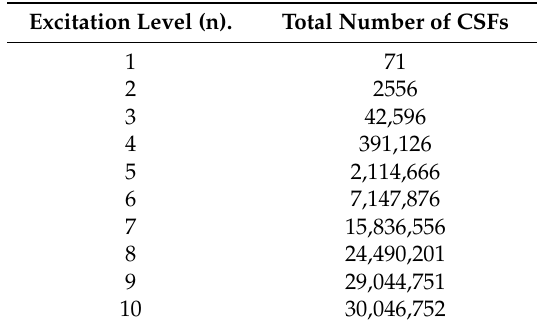
Table 1. The number of CSFs as a function of excitation level for H 2 O with a 6-31G(d) basis. Excitation Level